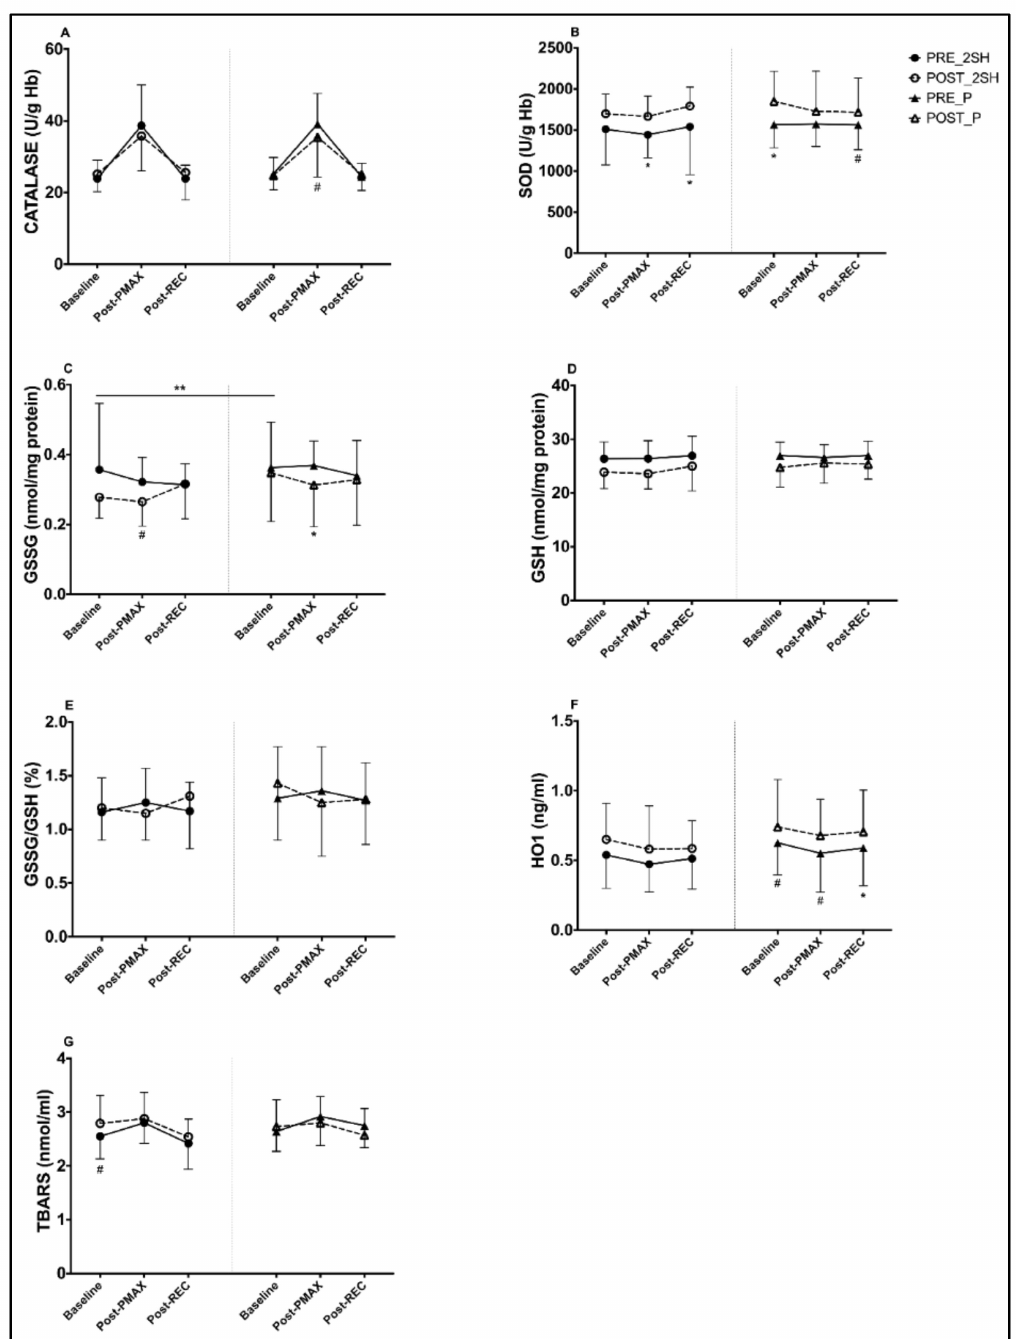
Figure 2. Differences between pre- and post-intervention intragroup in antioxidant and oxidant parameters at different points of the rectangular test ( A – G ). ( C ), a significant difference ( p = 0.04) appears, comparing baseline of the second rectangular test between groups. * p < 0.05. # p = 0.05–0.06. ** p < 0.05 between post-intervention time points of rectangular test between groups (2S-hesperidin vs.